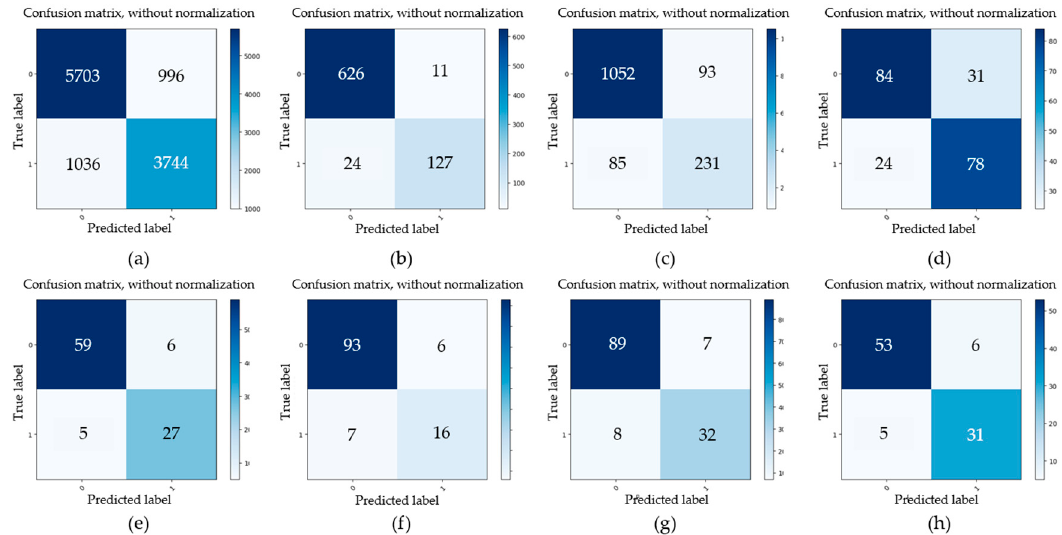
Figure 9. Detection results under different pitting levels. (a) Initial pitting; (b) Initial local pitting; (c) Moderate local pitting; (d) Severe local pitting.